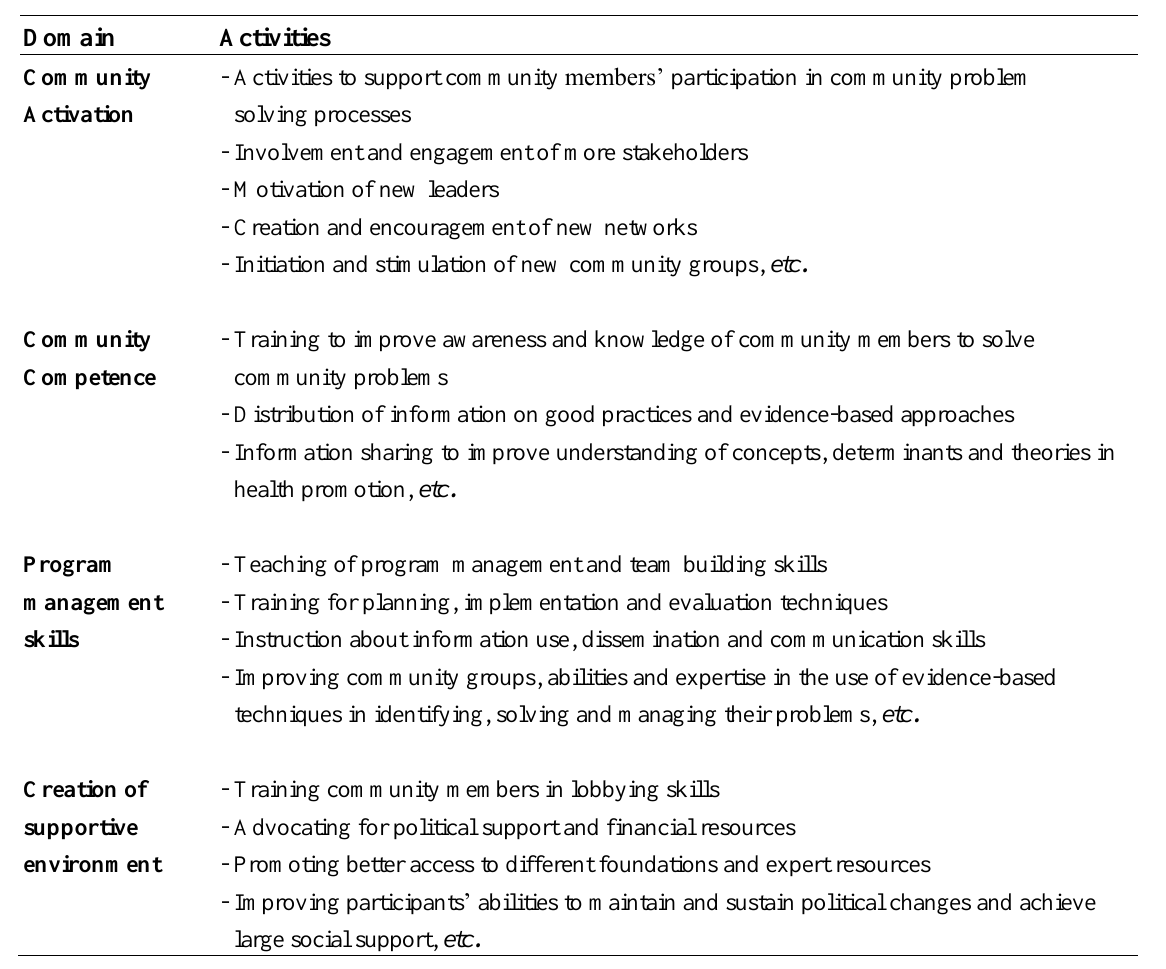
Table 2. Organizational domains of community empowerment and corresponding activities identified by Rapla community